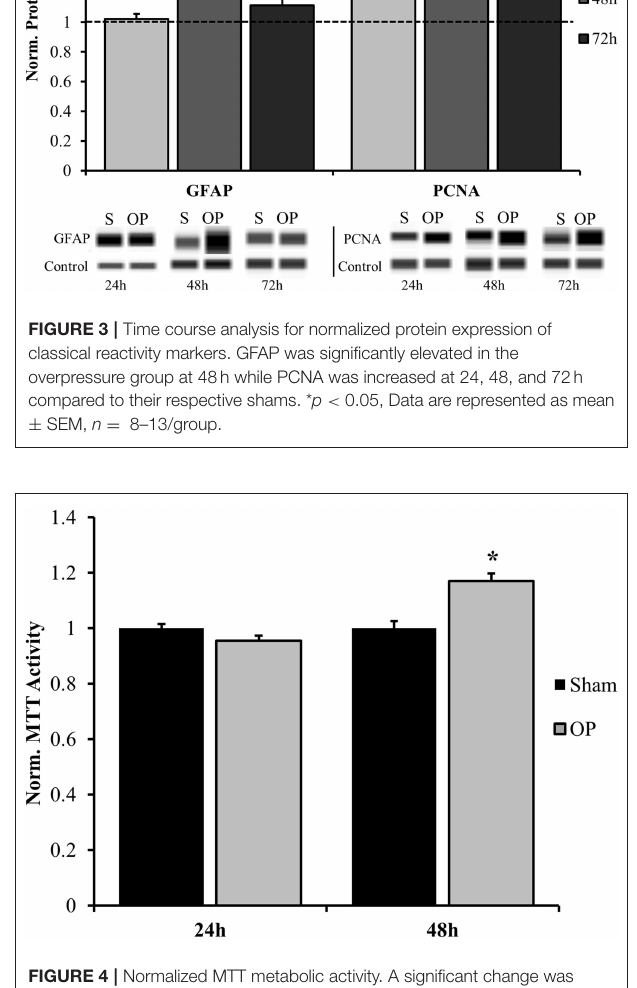
FIGURE 4 | Normalized MTT metabolic activity. A significant change was observed at 48h after overpressure exposure as compared to sham. * p < 0.05, Data are represented as mean ± SEM, n =